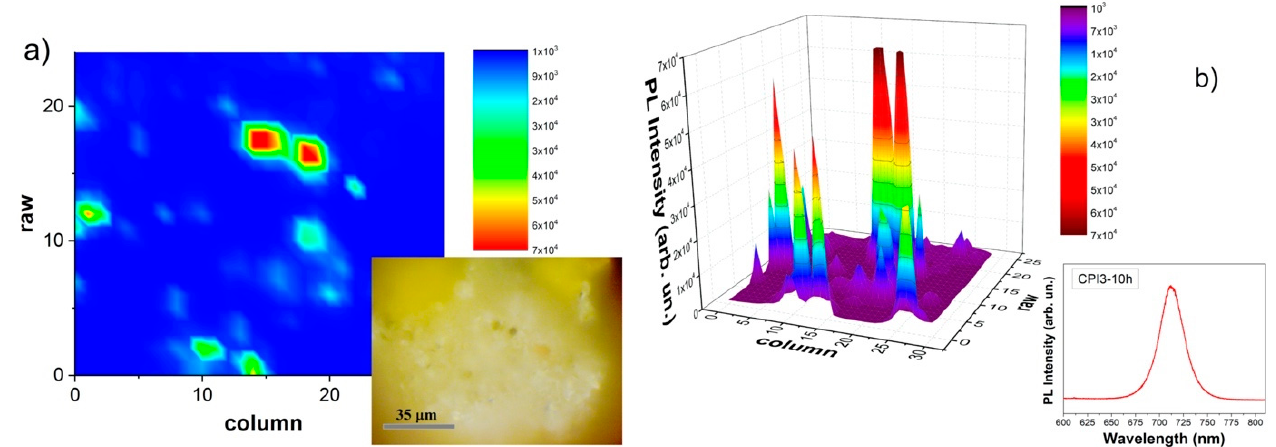
Nanomaterials 2021 , 11 , x FOR PEER REVIEW Figure 6. Luminescence map of the emissions at 715 nm of the sample CPI3-10 h: in ( a ), a 2D map and, in the inset, the image through optical microscope and in ( b ), a 3D map and, in the inset, the PL emission spectrum.